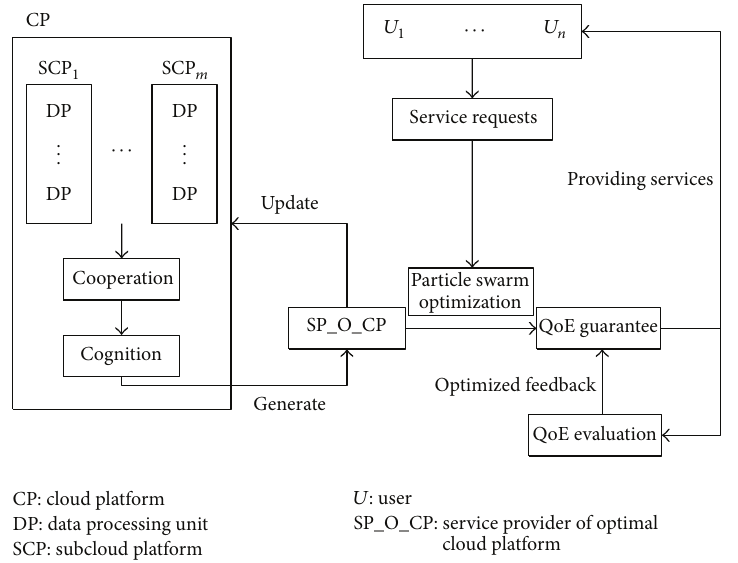
Figure 5: QoE guarantee mechanism